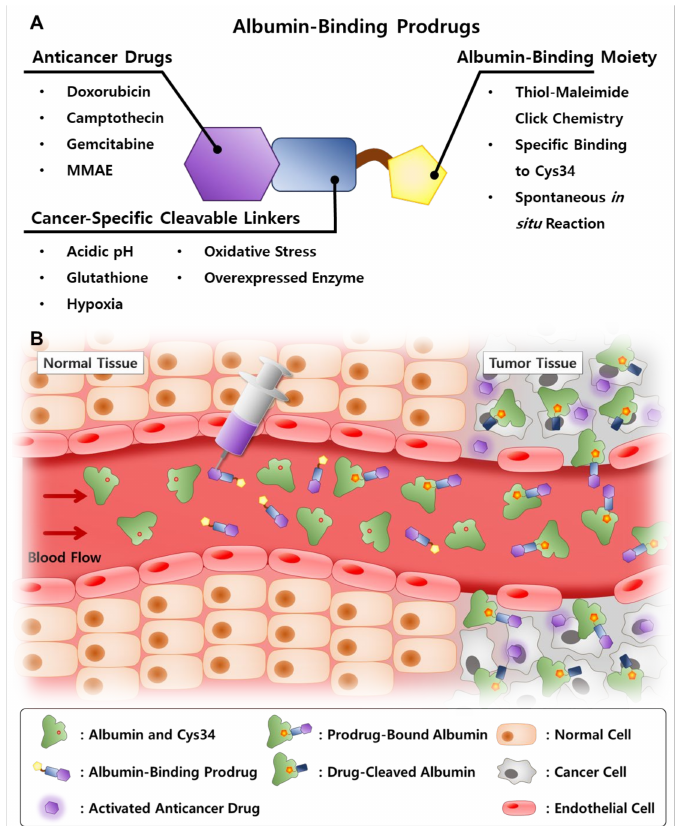
Figure 2. ( A ) Structure of the albumin-binding prodrug and explanations about each constituent. ( B ) Schematic illustration of the mechanism of action of albumin-binding